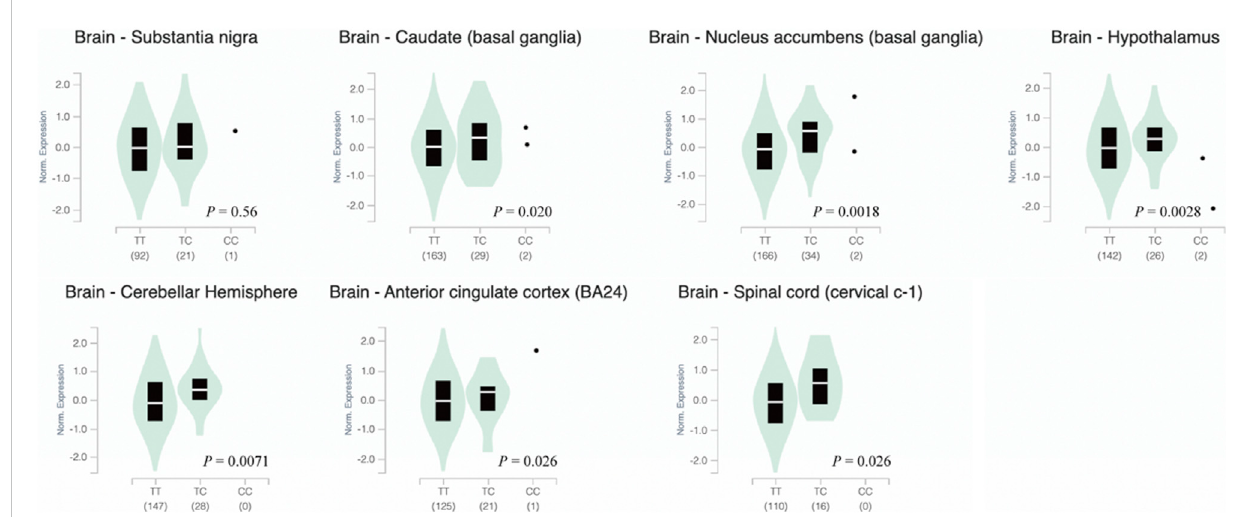
FIGURE 1 Violinplotsof P2RY11 expressioninhumanbraintissuescarryingdifferent DNMT1 rs9305012genotype.DatawereobtainedfromGTEx.Signi fi cance wasconsideredat p < 0.05.The p valuewasfroma t -testthatcomparesobservednormalizedeffectsizetoanulloneof0.Normalizedeffectsizewasthe slope of the linear regression of normalized expression data versus the three genotype categories using single-tissue eQTL analysis. DNMT1, DNA methyltransferase 1; eQTL, expression quantitative trait locus; P2RY11, purinergic receptor P2Y, G-protein coupled,